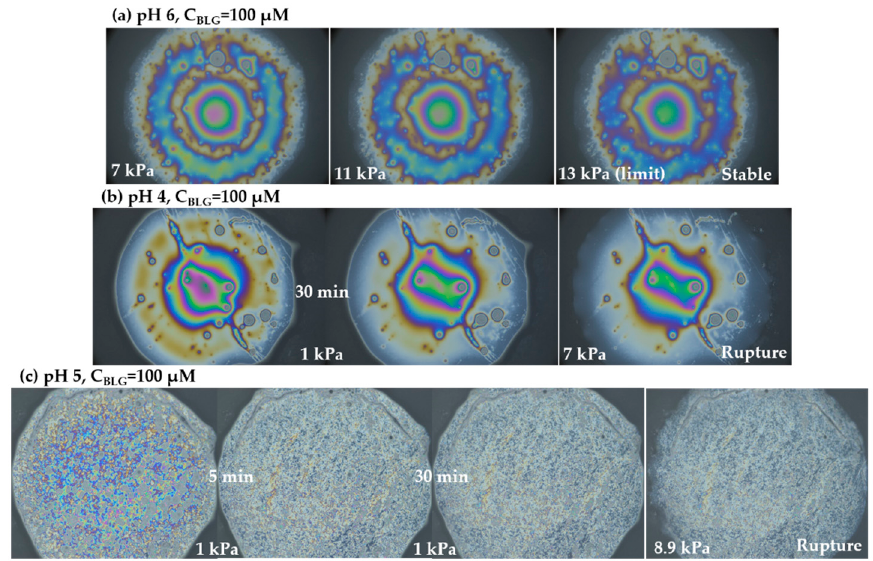
protocol ‘B’ (see Figure 6 c ).